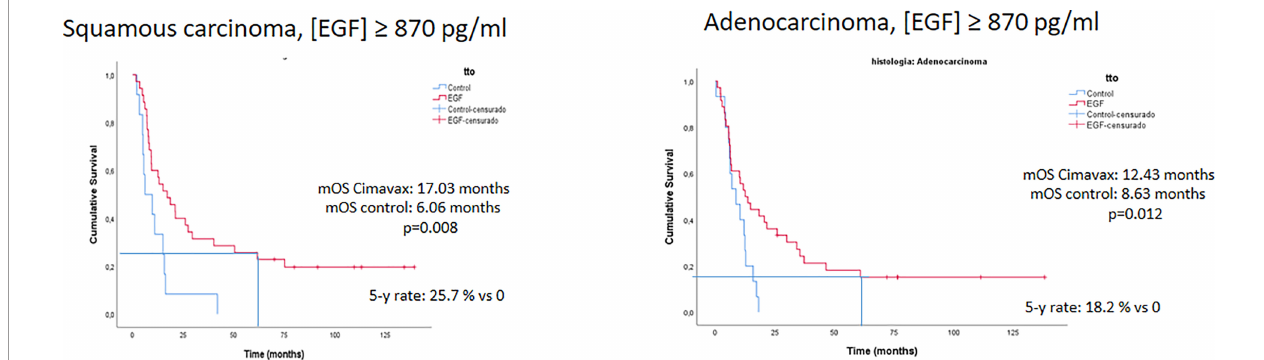
FIGURE 3 | Survival advantage of EGF deprivation therapy over best supportive care according to serum EGF concentration and tumor histology: 5 years update of the phase